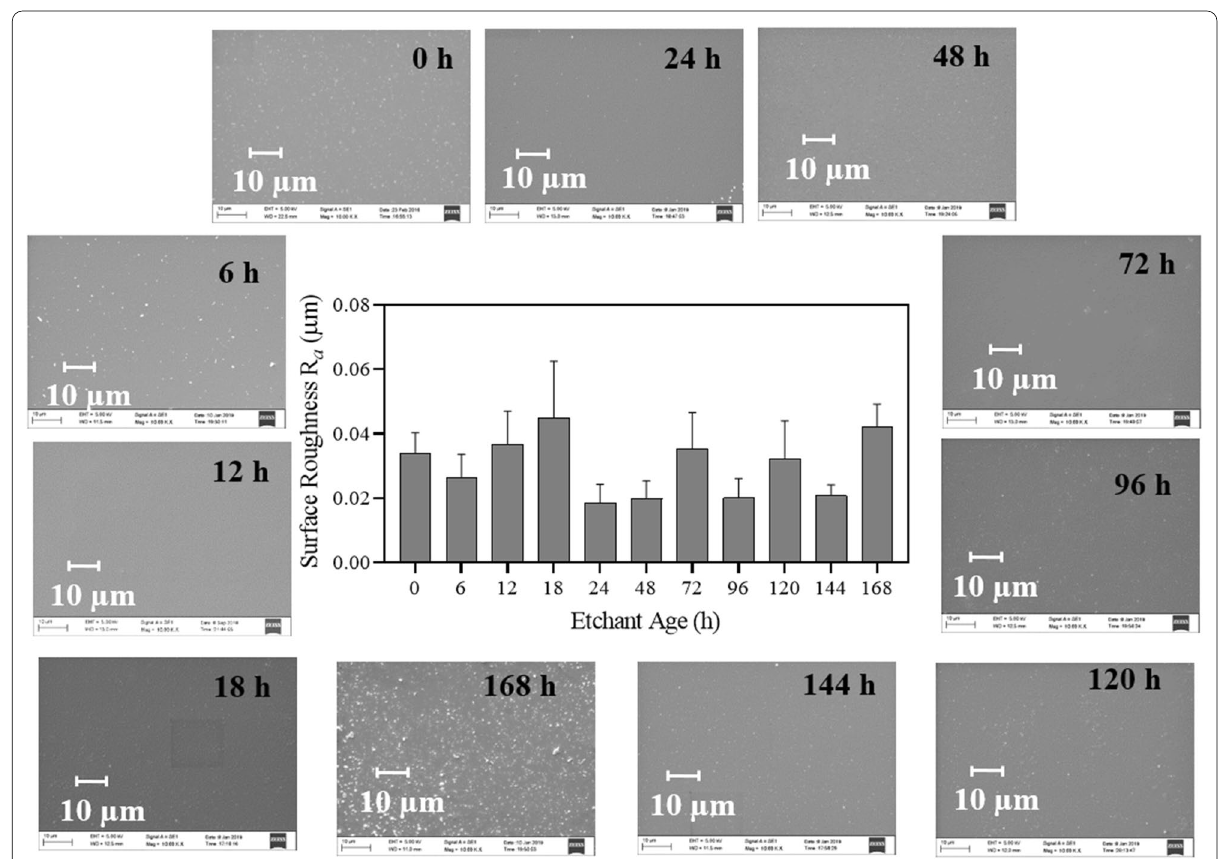
Fig. 48 Surface roughness (Ra) and corresponding surface morphologies of Si{100} with aging time of 15% NH 2 OH-added 20 wt% KOH